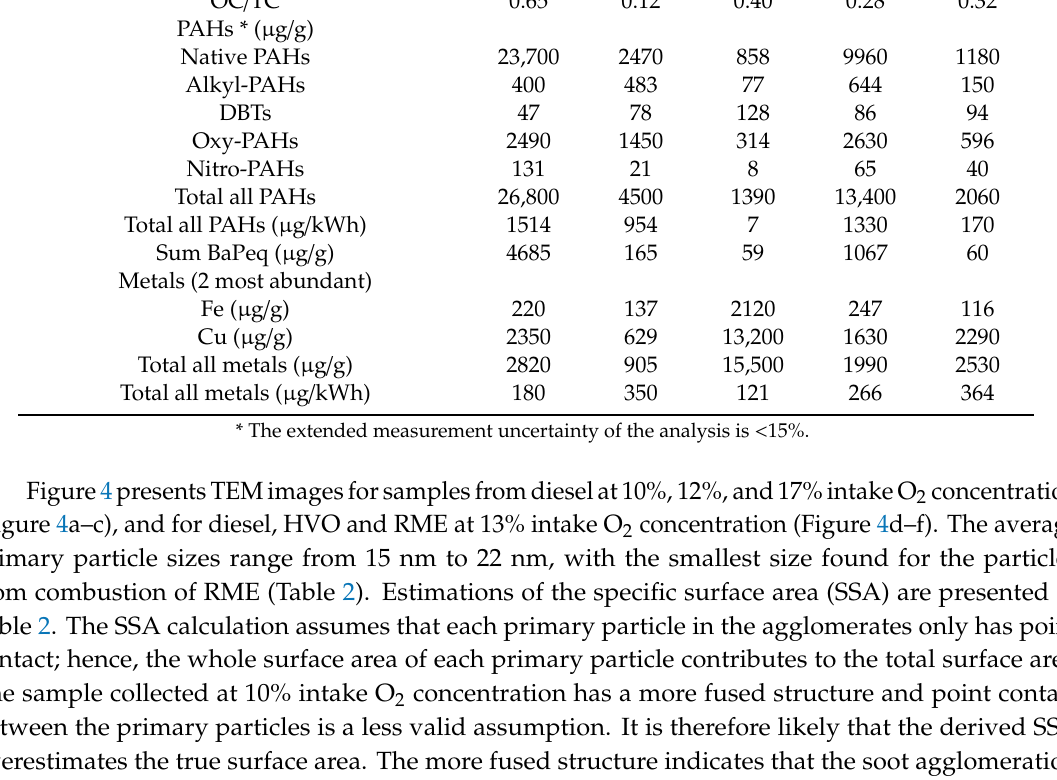
Table 2. The SSA calculation assumes that each primary particle in the agglomerates only has point contact; hence, the whole surface area of each primary particle contributes to the total surface area. The sample collected at 10% intake O 2 concentration has a more fused structure and point contact between the primary particles is a less valid assumption. It is therefore likely that the derived SSA overestimates the true surface area. The more fused structure indicates that the soot agglomeration occurs at di ff erent stages in the in-cylinder soot evolution process between the combustion at low and higher O 2 concentrations. On the other hand, the inherent material density has been shown to increase with soot maturity level [61]. The choice of a constant material density for all samples may therefore bias the SSA, making it too low for the less mature soot collected at 10% intake O 2